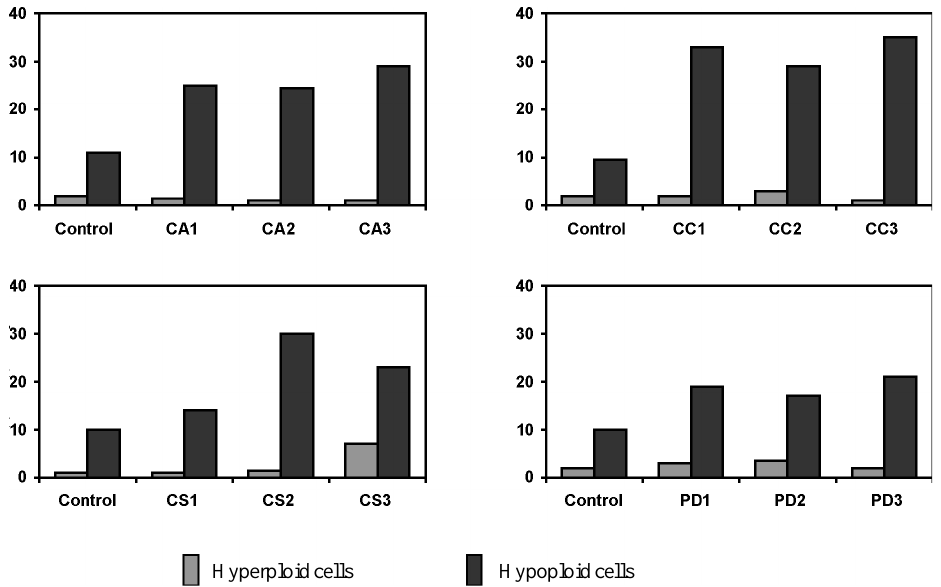
Figure 6 - Percentages of hypoploid and hyperploid MRC-5 cells after treatment with cacodilic acid doses of 1.25 x 10 -2 mM (CA1), 2.5 x 10 -2 mM (CA2) and 5.0 x 10 -2 mM (CA3); cadmium chloride doses of 1.0 x 10 -3 mM (CC1), 2.0 x 10 -3 mM (CC2) and 4.0 x 10 -3 mM (CC3); cadmium sulfate doses of 3.3 x 10 -5 mM (CS1), 6.7 x 10 -5 mM (CS2) and 1.3 x 10 -4 mM (CS3), and potassium dichromate doses of 2.5 x 10 -4 mM (PD1), 5.0 x 10 -4 mM (PD2) and 1.0 x 10 -3 mM (PD3).